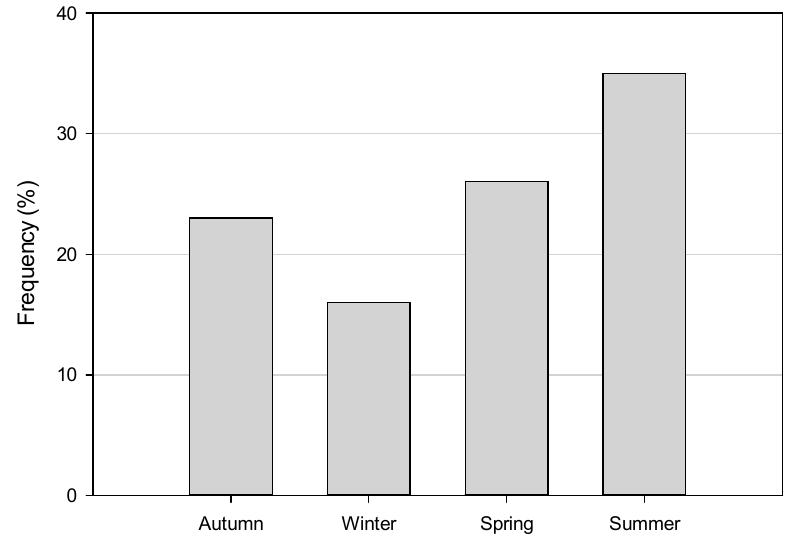
Figure 3. Incidents of children left unattended in motor vehicles by season.